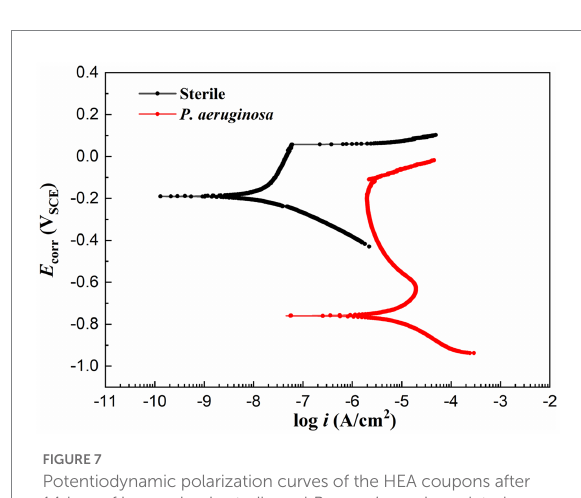
FIGURE 6 Equivalent electrical circuits simulating the EIS diagrams.